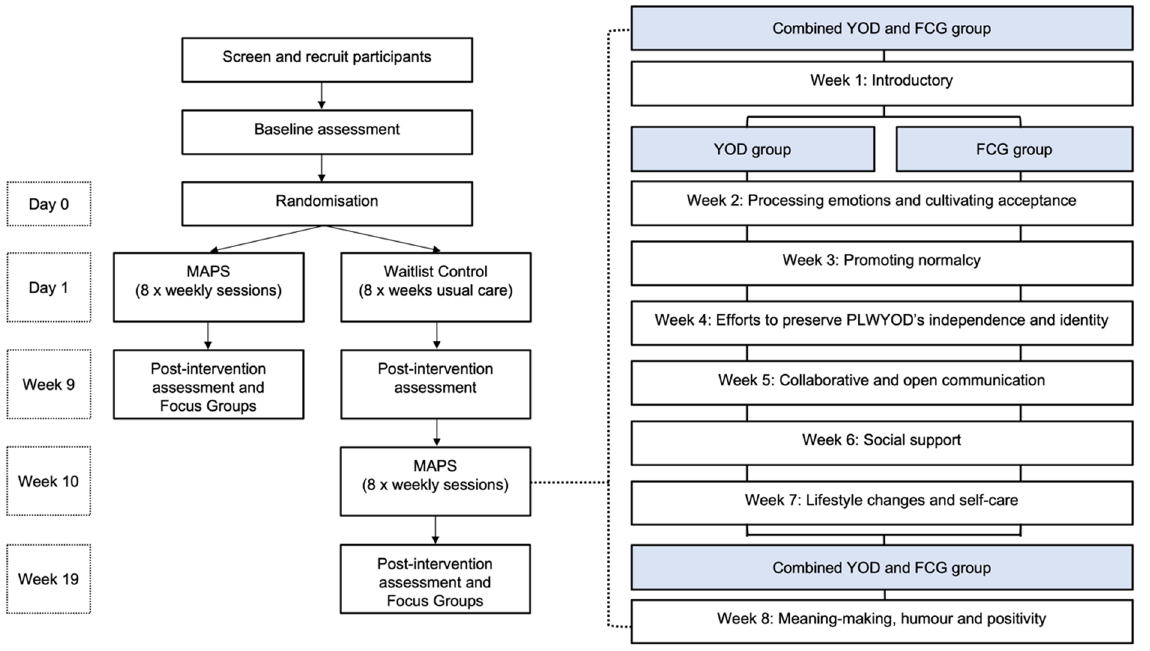
Figure 1. Structure of the program (FCG family caregivers; MAPS Music And Psychology & Social connections; YOD younger-onset dementia).